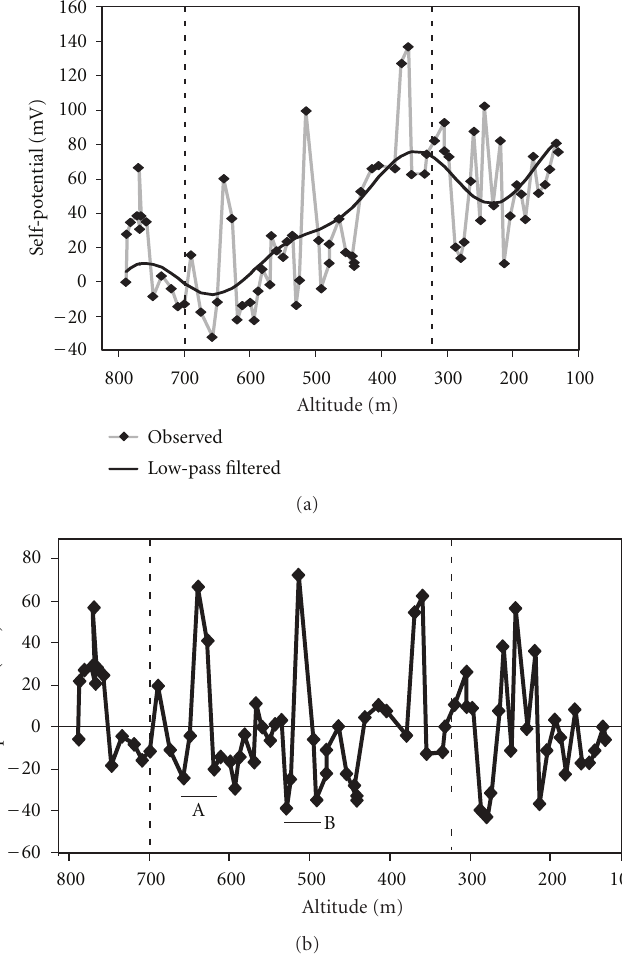
Figure 5: (a) The observed raw SP profile (gray line with diamonds) and low-pass filtered one called as “regional” pattern in this study (solid line). (b) Residual SP profile after subtracting regional SP from raw data, called as “local”